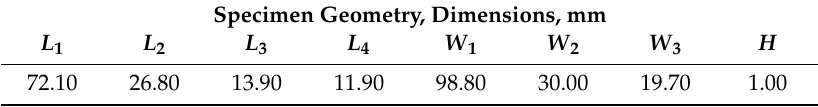
Figure 6. HL3DEM numerical model of antenna proposed for RFID sensor. Table 1. Dimensions of designed antenna in accordance with designations in Figure